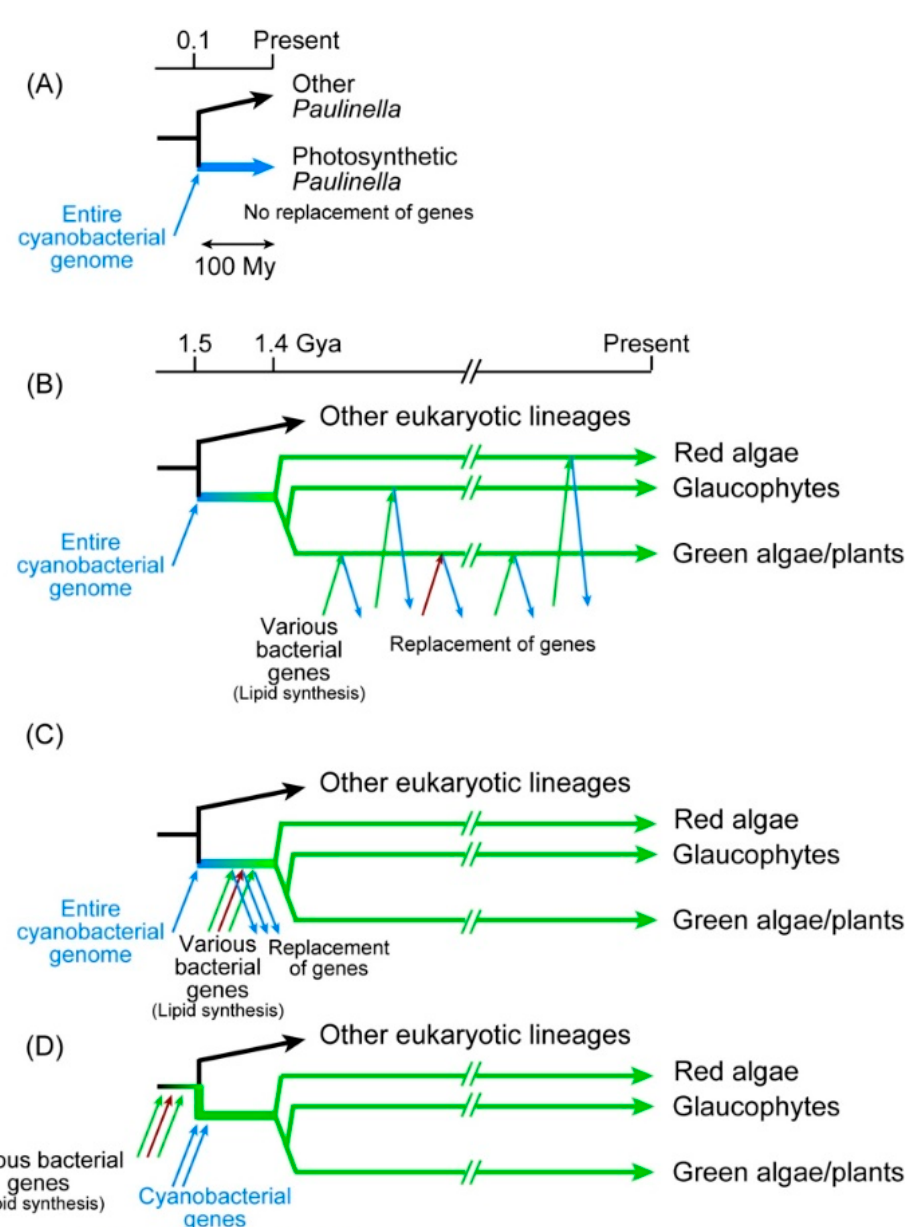
Figure 4. Various scenarios on the origin of non-cyanobacterial proteins in the chloroplast. ( A ) The chromatophore of Paulinella is a reference, in which all components originate essentially from cyanobacteria. ( B – D ) Various possible versions of explanations for the non-cyanobacterial proteins in chloroplasts. ( B ) Cyanobacterial proteins introduced by the primary endosymbiosis were replaced by horizontal gene transfers during the long evolution of plants and algae. ( C ) Non-cyanobacterial proteins that are conserved in the three lineages must have been introduced before the divergence of the three lineages. ( D ) Non-cyanobacterial proteins might be introduced before chloroplast formation as a pre-adaptation. Note that the time ranges of chromatophore evolution and chloroplast diversification are about the same (100 million years). See text for details. The colors are used to indicate different lineages, such as cyan for cyanobacteria and green for chloroplast.